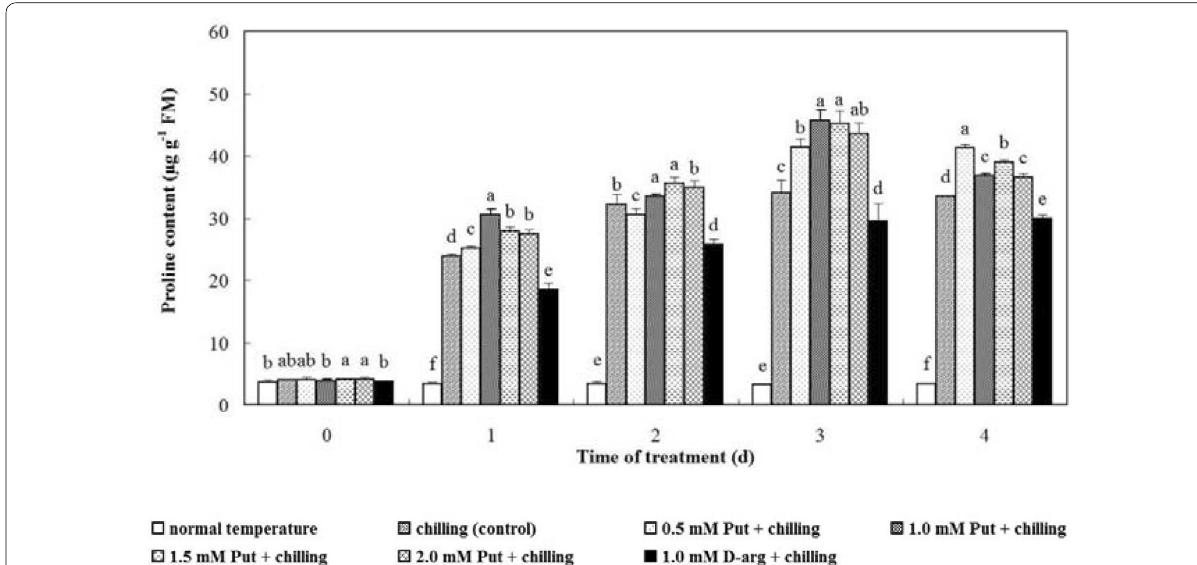
Fig. 4 Effects of exogenous Put and d -arg on the proline content in the leaves of anthurium seedlings under chilling stress. Seedlings were treated with normal temperature, chilling (control), 0.5 mM Put d -arg + chilling for 3 days and a recovery for 1 day, and proline content in the leaves was assayed. Each point represents the mean ± SE (n = 5). Treatments marked with different letters at a given sampling date are significantly different at P <